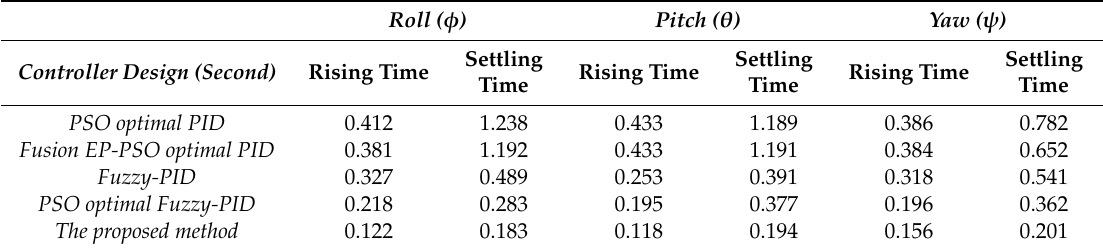
Table 4. The response performances in comparison.